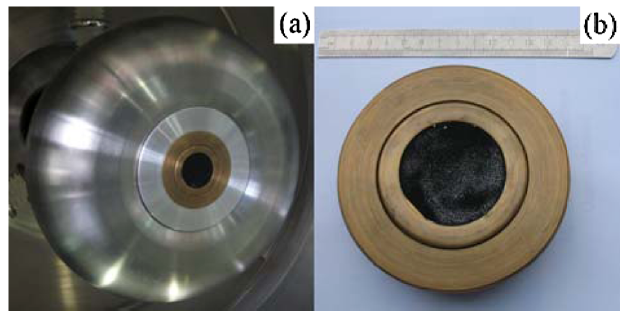
FIG. 2. Cathode of the 2 MeV LIA injector diode: (a) cathode, (b) CNT cathode and bronze subassembly.